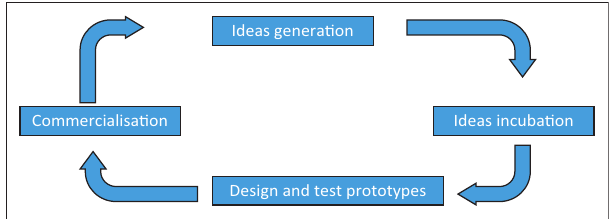
FIGURE 1: The entrepreneurship